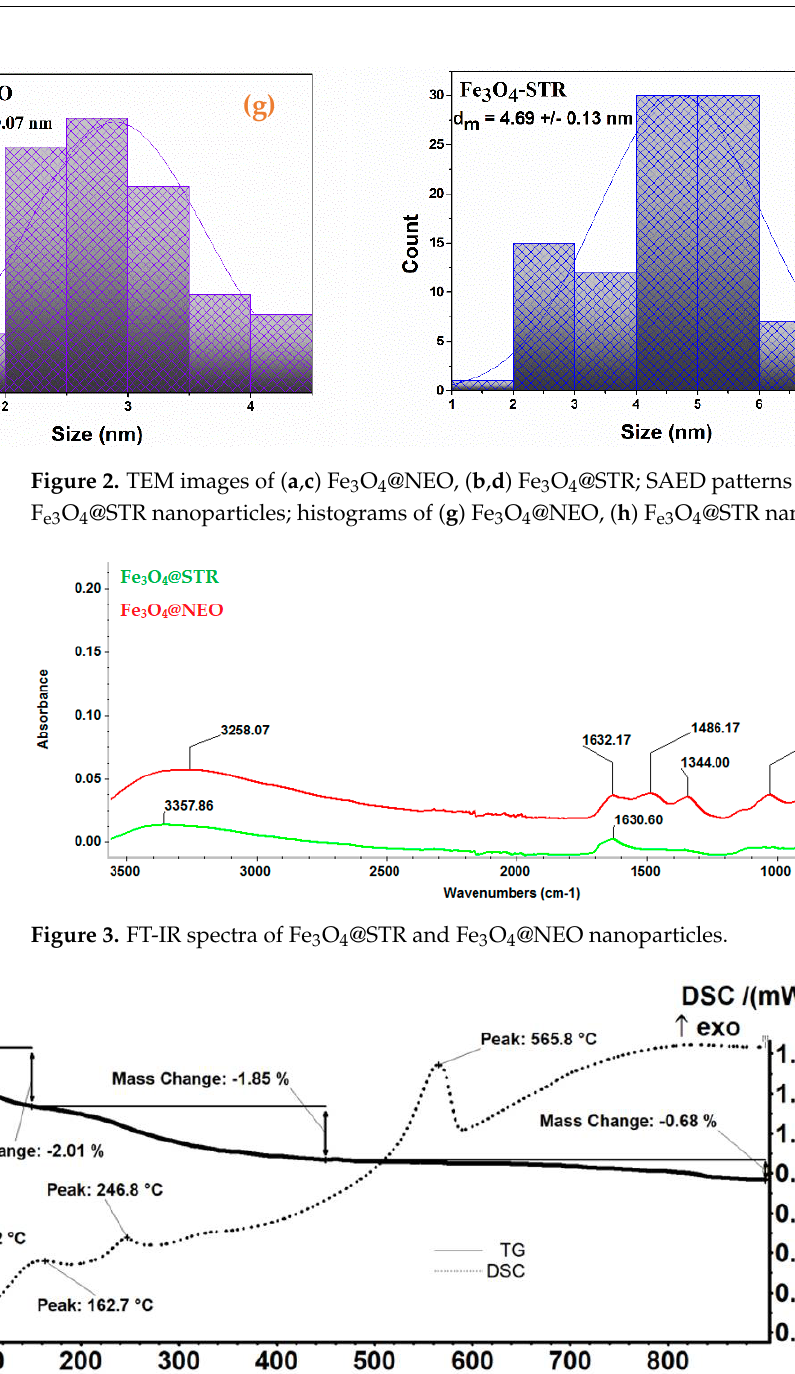
Figure 3. FT-IR spectra of Fe 3 O 4 @STR and Fe 3 O 4 @NEO nanoparticles.